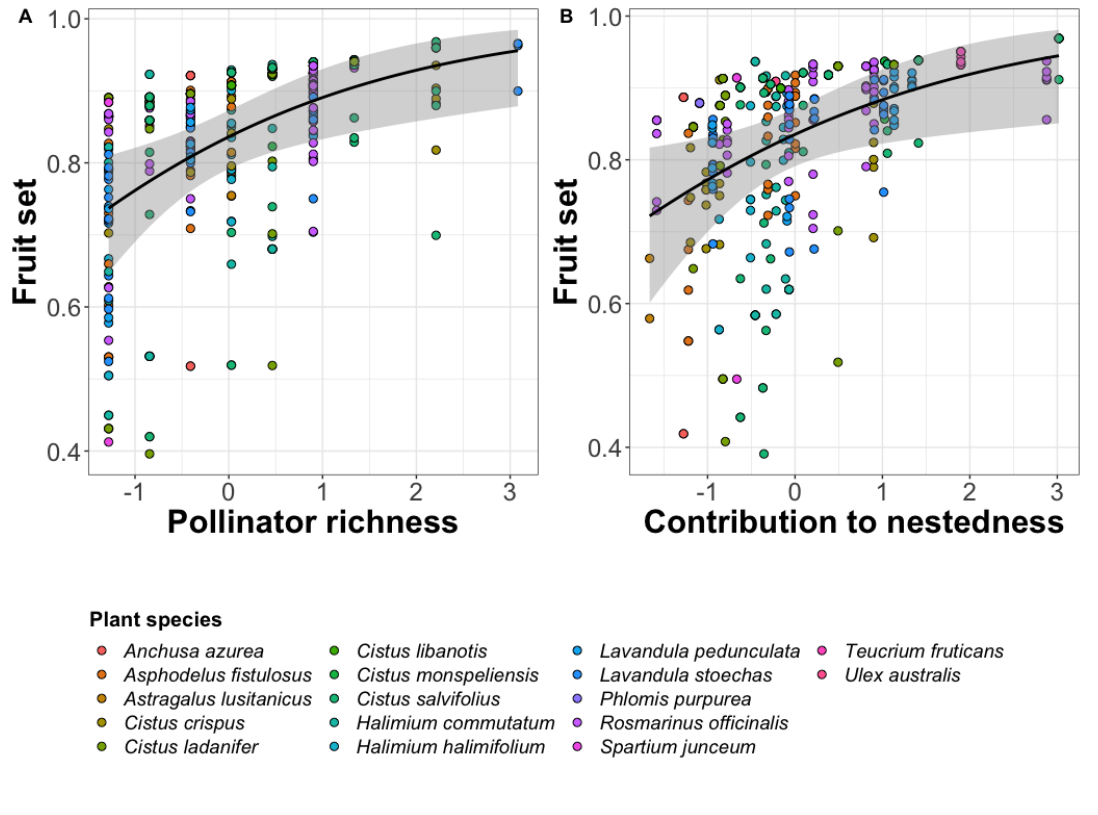
Figure 1. Partial residual plots showing the effect of A) pollinator species richness and B) the contribution to nestedness of each plant species on fruit set. Dots represent each of the individuals sampled for each species within each